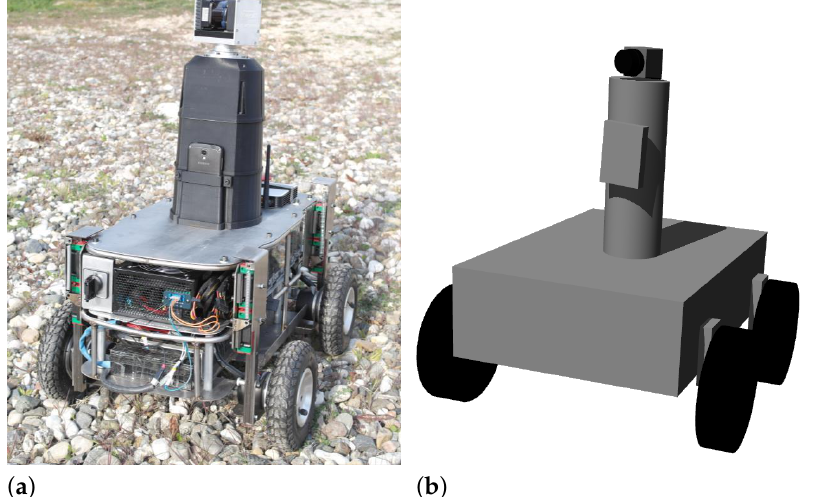
Figure 1. The mobile robot Andabata ( a ) and its simplified hardware model in Gazebo ( b